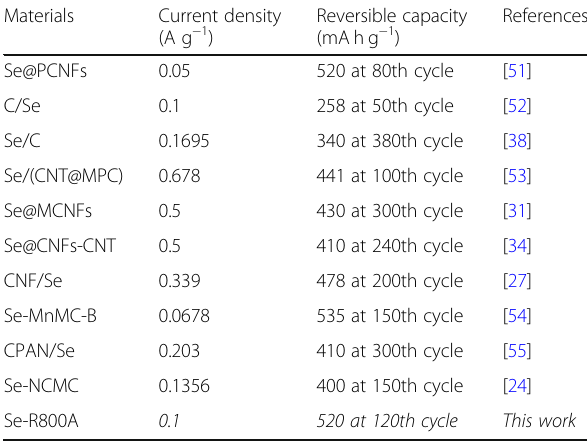
Table 1 The comparison of cycling performance for the C-Se cathodes for Na-Se batteries reported in